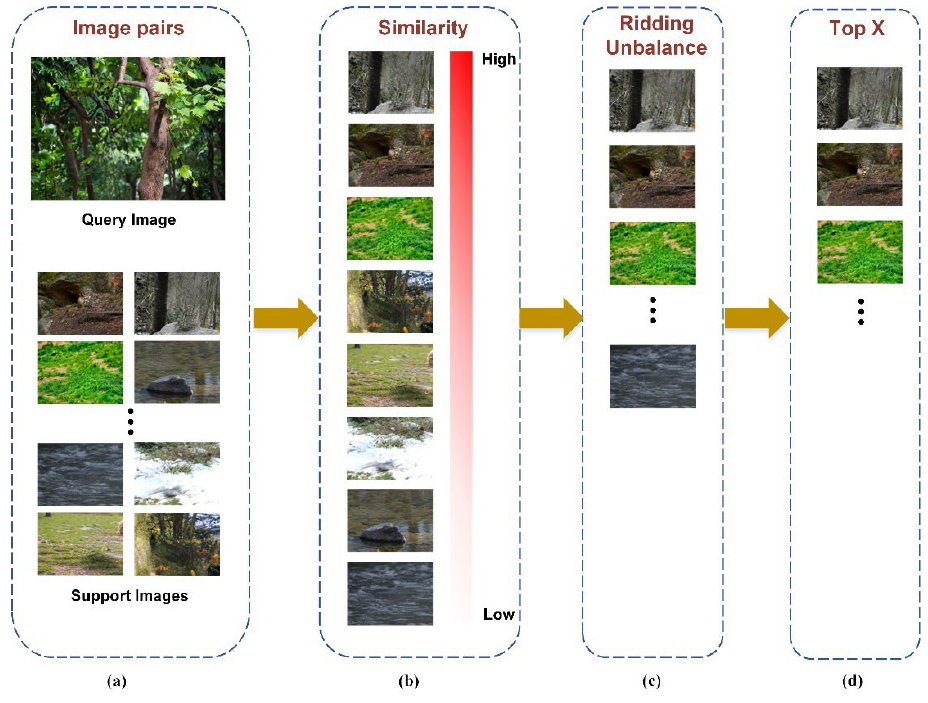
Figure 3. Filtering similar background processes: ( a ) calculating the Hamming distance between pairs of images; ( b ) sorting them in descending order by similarity; ( c ) removing the remarkably similar samples to ridding unbalance; ( d ) selecting the top 60% of reasonable samples, as those that could be subsequently blended for the front and back views.